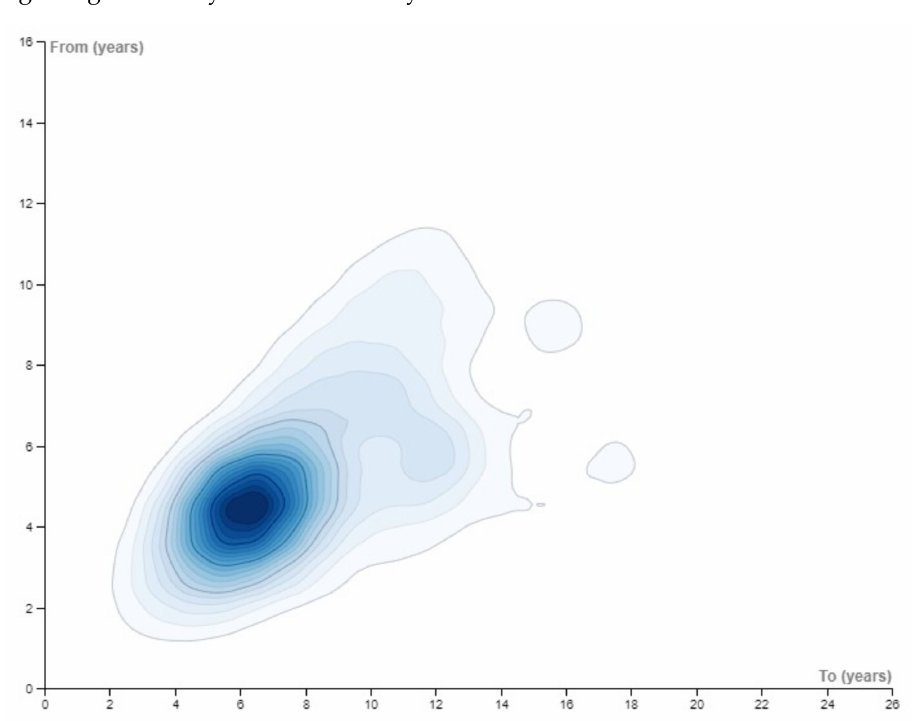
Figure 4. Distribution of studies according to the age range of the samples